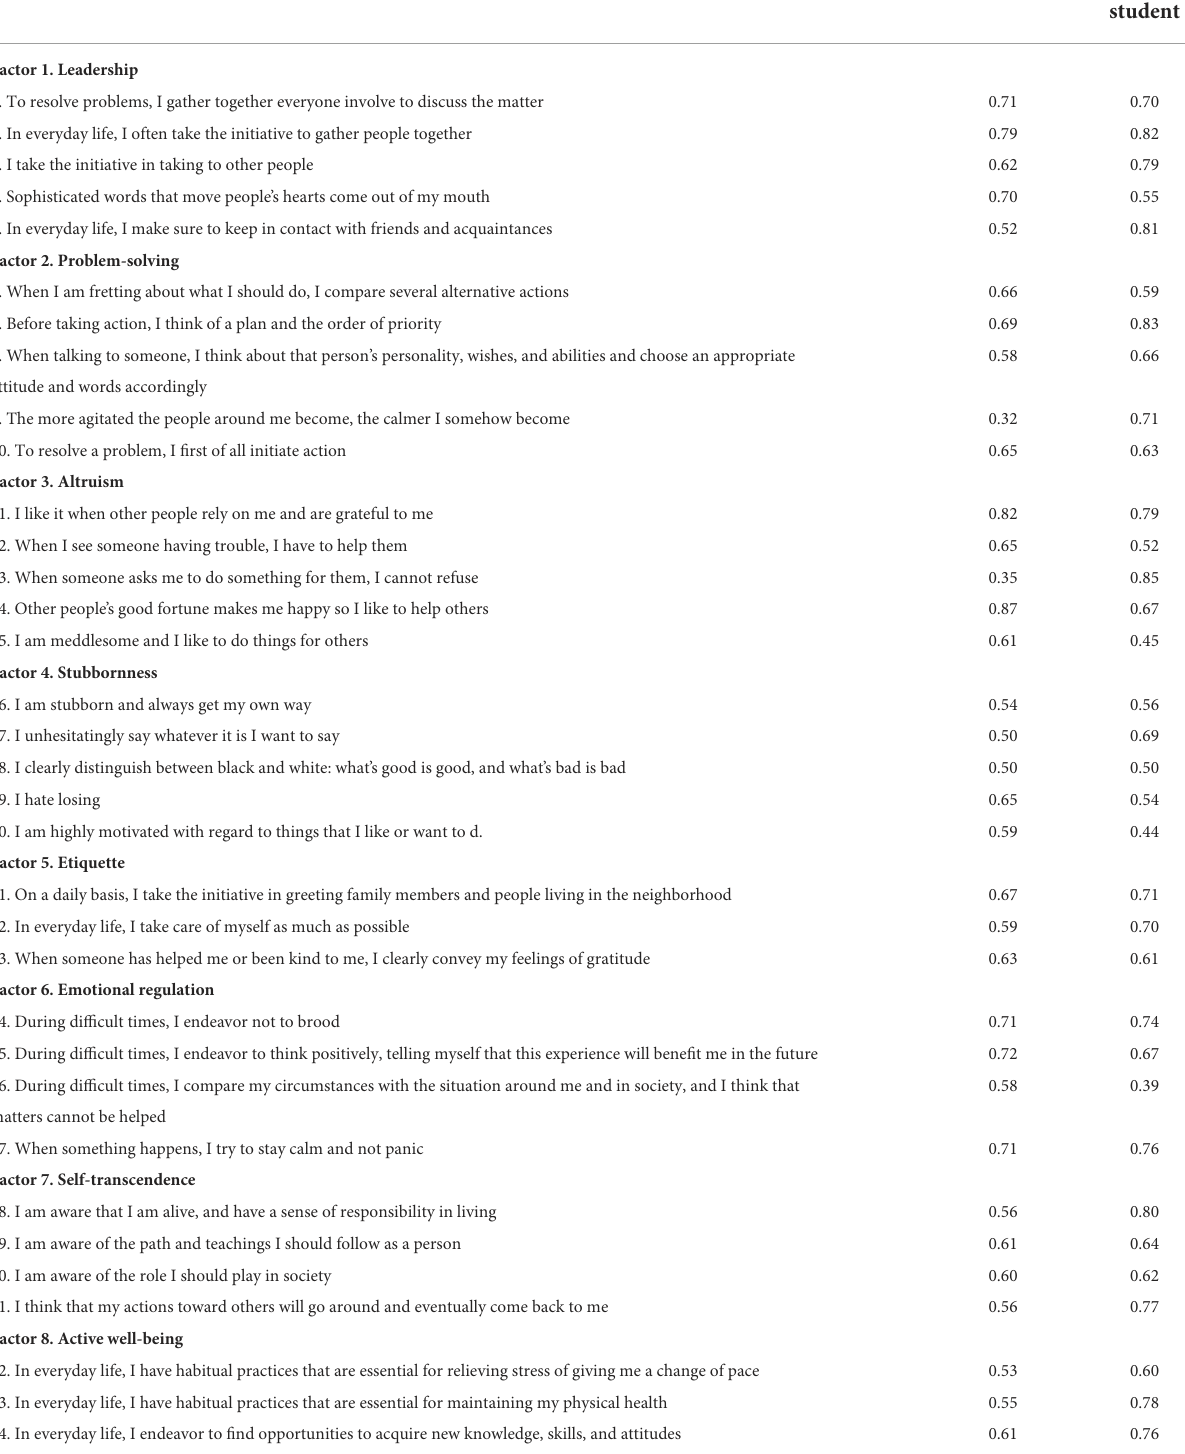
TABLE 1 Power to live questionnaire and factor loading in elementary and junior high school students (34-item factor